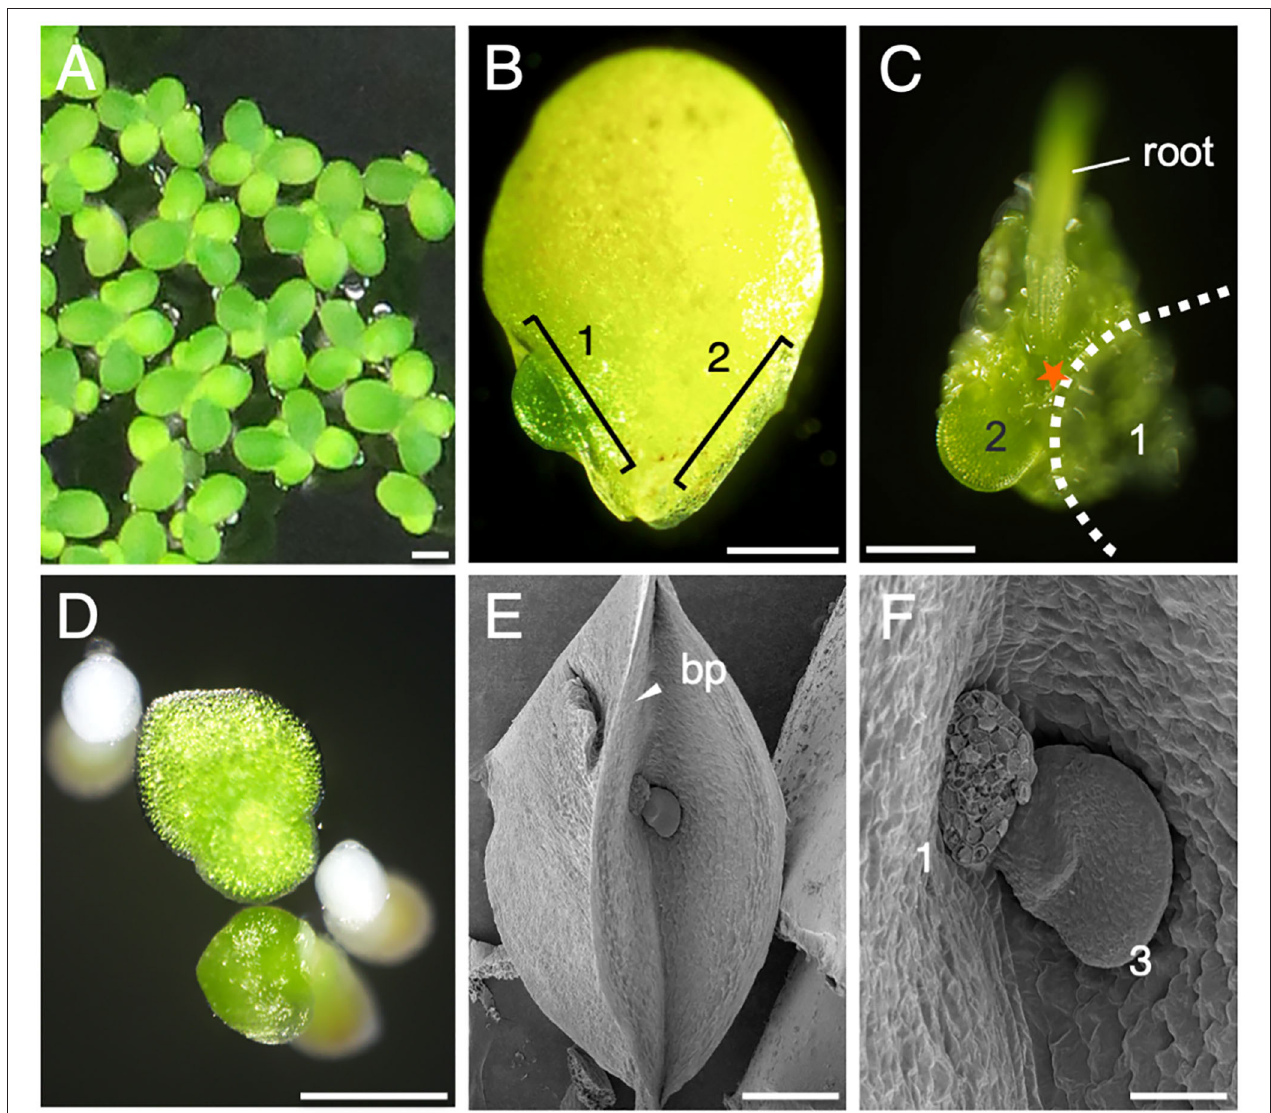
FIGURE 1 | Frond development. (A) L. aequinoctialis growing in liquid culture. (B) Close-up view of a single frond. The locations of two budding pouches are identified by brackets: (1) the larger daughter frond and (2) the smaller daughter frond is covered by the mother frond and is out of view. (C) The abaxial side of a frond whose larger daughter frond (1) was removed for observation. The position of the missing frond is depicted as a dotted line. The smaller daughter frond is labeled as 2. (D) Fronds after germination. (E) Scanning electron micrograph of a budding pouch (bp). (F) Close-up view of (E) showing the early development of a third daughter frond (3). Scale bars: 1cm (A) , 1mm (B) , 0.5mm (C–E) , and 100 µ m (F) .